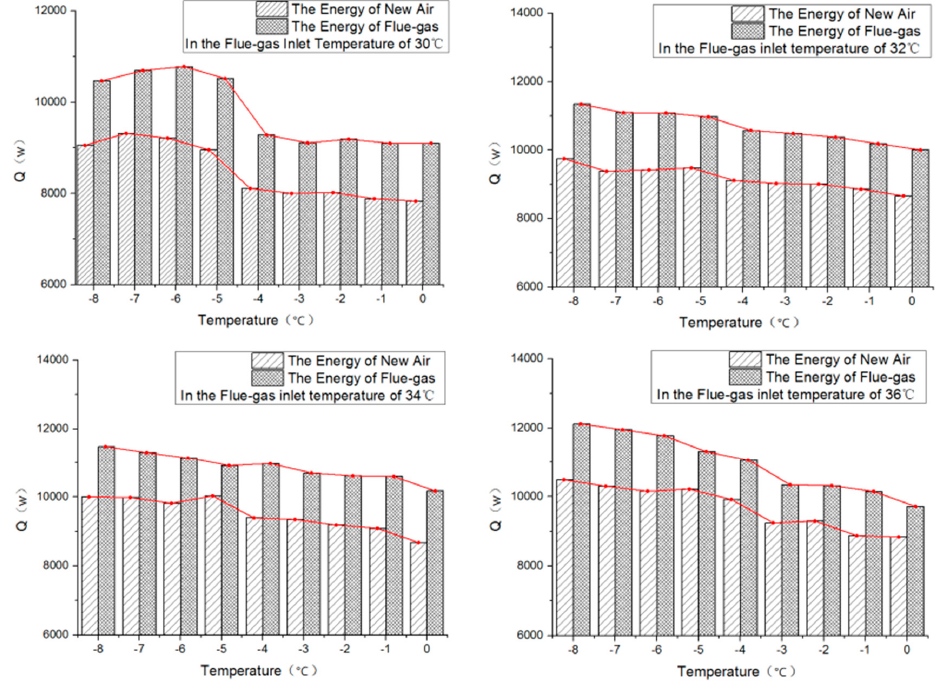
Figure 7. Energy consumption and saving of heat exchangers.